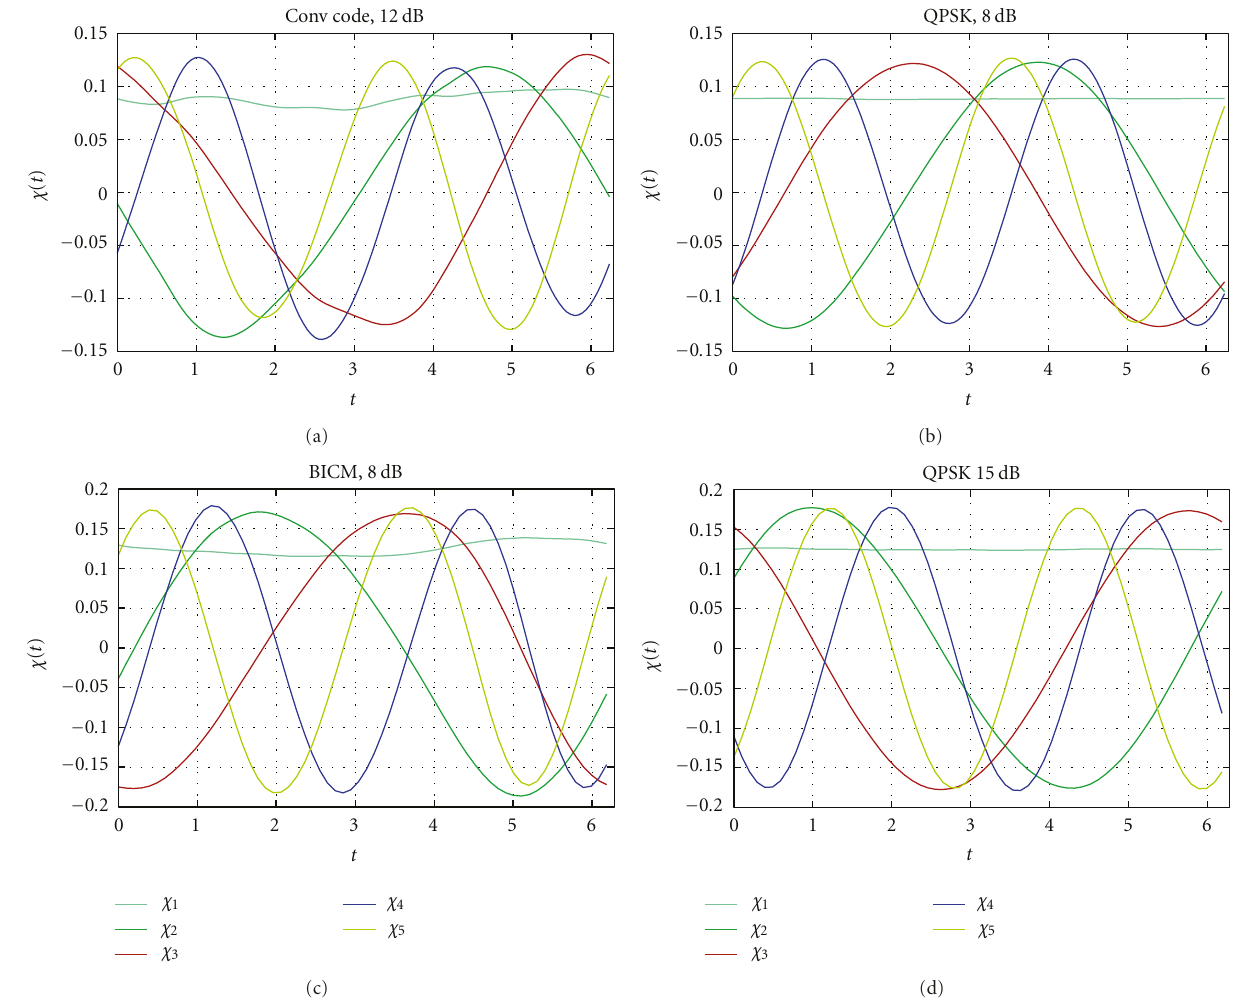
Figure 7: The eigenfunctions resulting from di ff erent